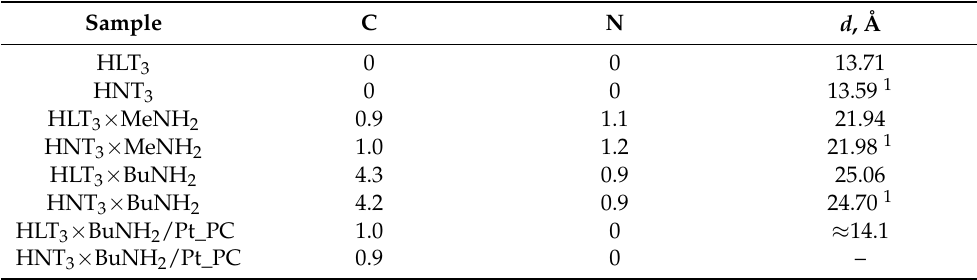
Table 1. The content of carbon and nitrogen per formula unit of the layered oxide determined by CHN analysis and the interlayer distance d for the samples of protonated (HLT 3 and HNT 3 ), methylamine- intercalated (HLT 3 × MeNH 2 and HNT 3 × MeNH 2 ) and n -butylamine-intercalated (HLT 3 × BuNH 2 and HNT 3 × BuNH 2 ) layered titanates, and the platinized samples after photocatalytic experiments (HLT 3 × BuNH 2 /Pt_PC and HNT 3 × BuNH 2